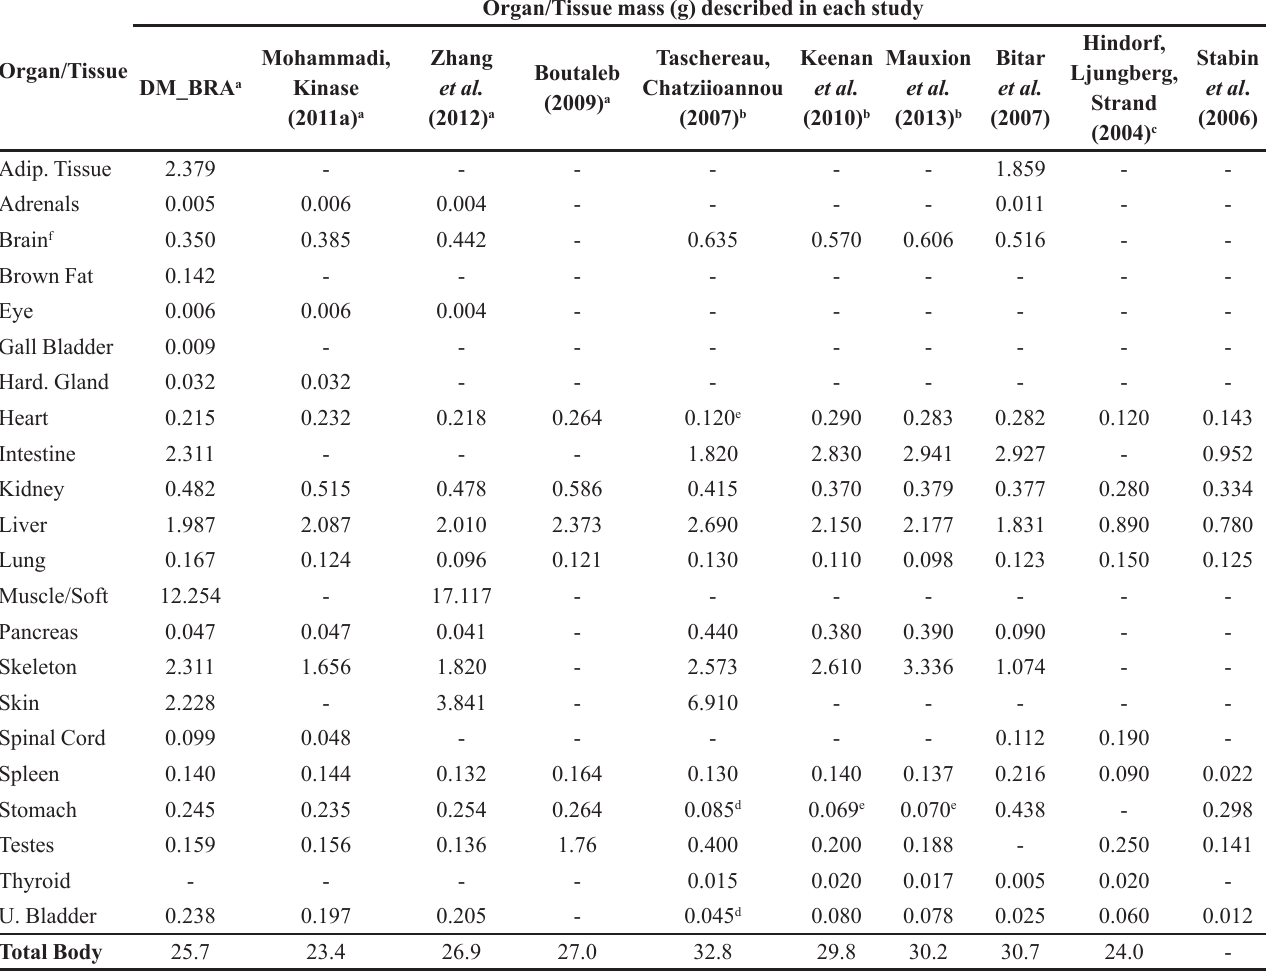
TABLE II - Organ and tissue masses segmented on DM_BRA and other voxel models available in literature Organ/Tissue mass (g) described in each study Organ/Tissue